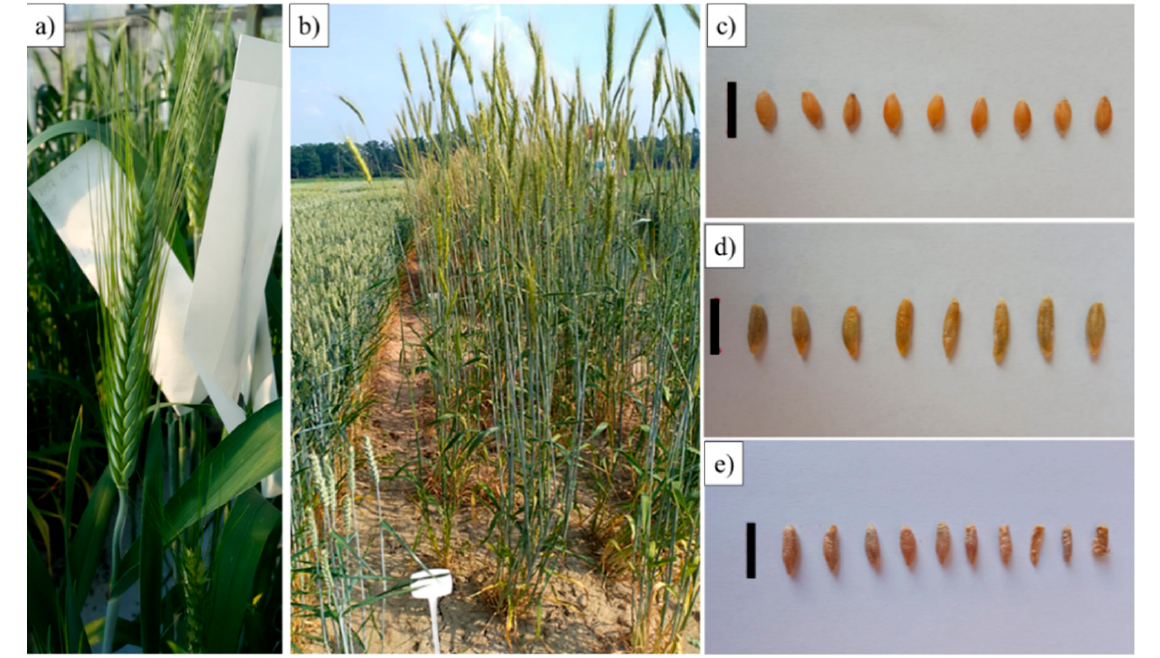
Figure 7. Spike ( a ) and whole plants ( b ) of S 4 generation of tetraploid triticale. Seeds of: ( c ) Triticum monococcum (PI 191383), ( d ) Secale cereale (Dankowskie Hadron) and ( e ) tetraploid triticale (S 4 gen ‐ eration). Scale bars: 1 cm. Table 6. Statistics, analysis of variance followed by Tukey’s Honest Significant Difference test (HSD) of 8 yield ‐ related traits investigated among 60 plants of Triticum monococcum (PI 191383), Secale ce ‐ reale (Dankowskie Hadron) and amphiploids (S4 generation): plant height (PHt), stem length (StL), spike length (SpL), number of spikelets per spike (SplPS), number of grains per spike (GPS), grain length (GL), grain width (GW) and thousand ‐ grain weight (TGW).